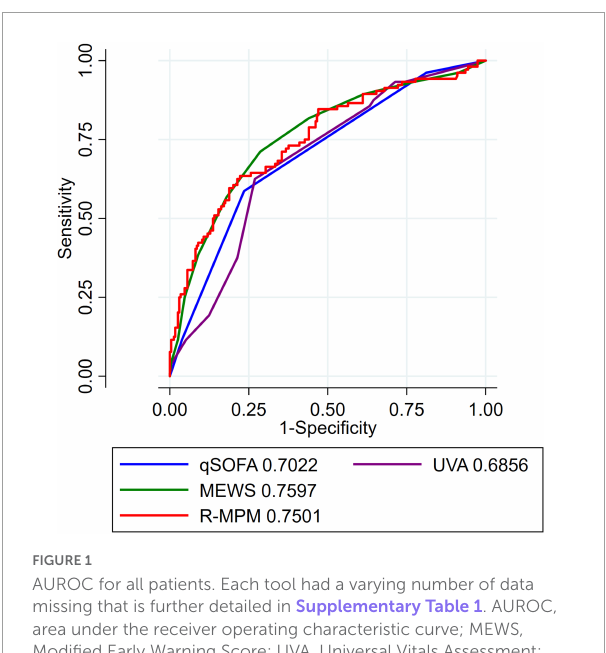
FIGURE1 AUROC for all patients. Each tool had a varying number of data missing that is further detailed in Supplementary Table 1 . AUROC, area under the receiver operating characteristic curve; MEWS, Modified Early Warning Score; UVA, Universal Vitals Assessment; qSOFA, quick Sequential Organ Failure Assessment; R-MPM, Rwanda Mortality Prediction Model.